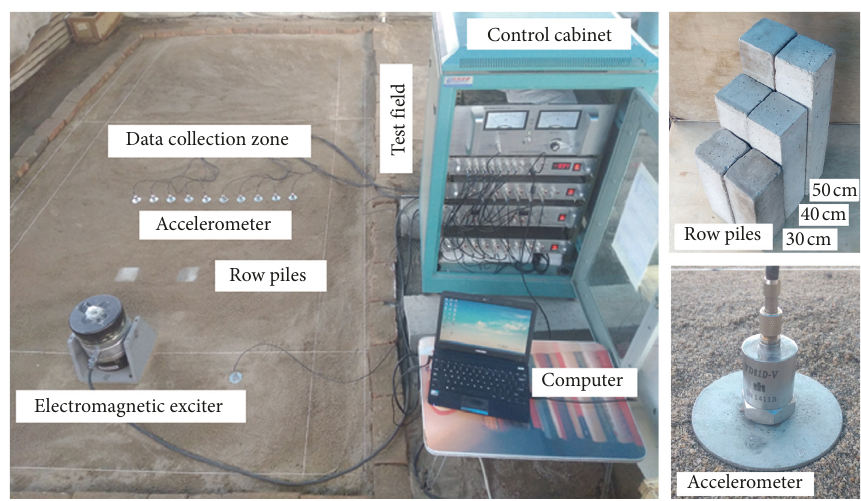
Figure 2: Details of the test